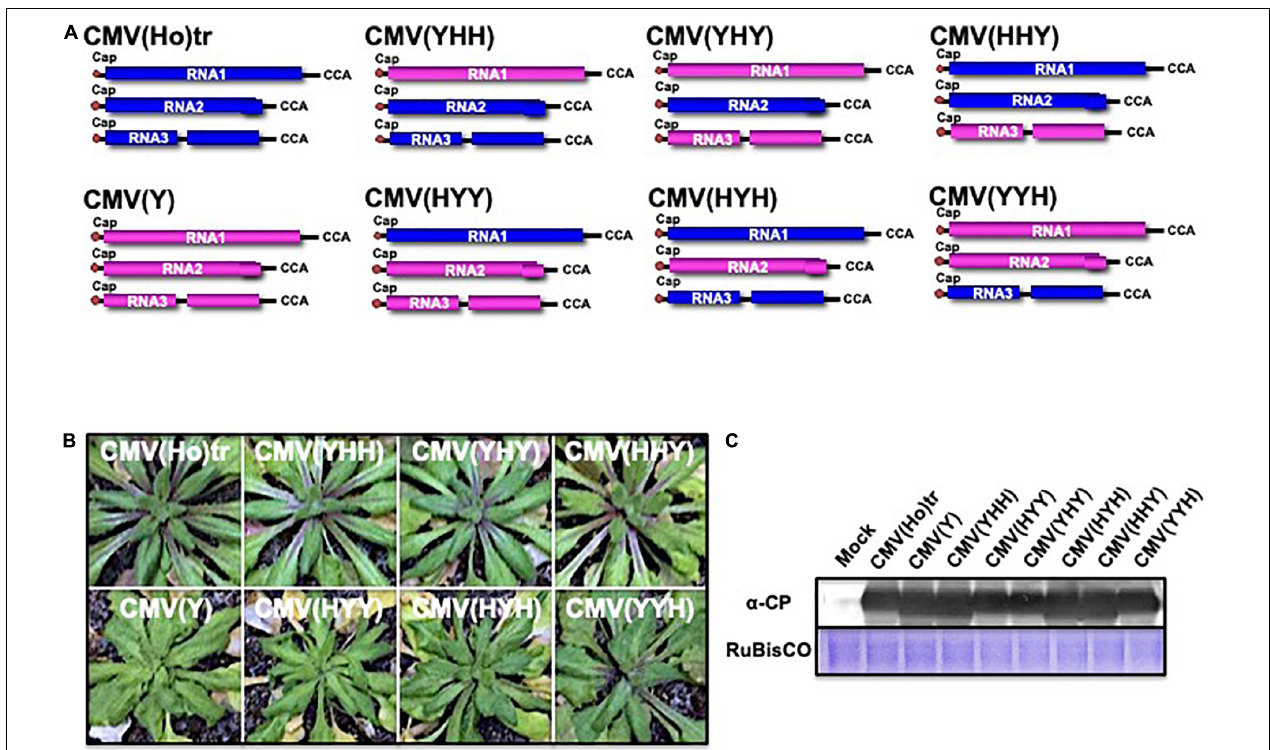
FIGURE 6 | The response of A. thaliana ecotype Col-0 to infection with reassortant CMVs. Fully expanded leaves of Col-0 plants were inoculated with a series of CMV reassortants from the parental strains CMV(Ho)tr (RNA segments colored blue) and virulent CMV(Y) (RNA segments colored red): CMV(YHH), CMV(YHY), CMV(HHY), CMV(HYY), CMV(HYH), or CMV(YYH), in which the position and letter refer to the RNA segment (1, 2, or 3) and origin of the parental strains, respectively (A) . The 5 (cid:48) -end of each RNA has a 7 mGpppG-cap structure (Cap), and the 3 (cid:48) -end of each RNA has the same nucleotide sequence (5 (cid:48) -CCA-3 (cid:48) ). Col-0 plants were inoculated with CMV(Ho)tr or virulent CMV(Y) as controls. Photographs of young leaves of Col-0 plants infected with a series of reassortant CMVs, CMV(Ho)tr, or virulent CMV(Y) at 14 dpi are shown (B) . CMV coat protein in virus-infected leaves was detected immunologically by western blotting (C) . As an internal control, RuBisCO was detected by CBB staining and shown in the lower